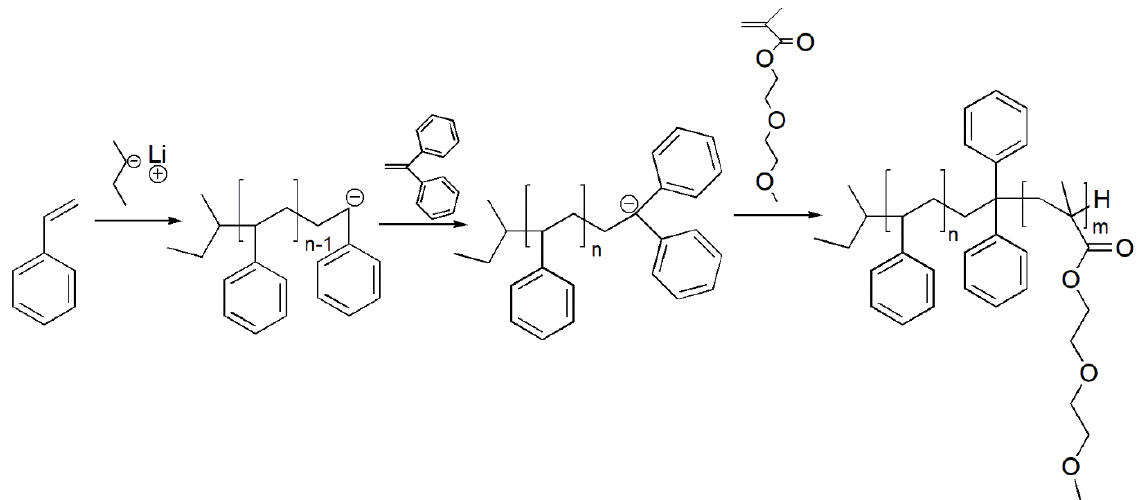
Figure 2. Reaction scheme of the synthesis of the PS-b- PDMEEMA block-copolymer by the